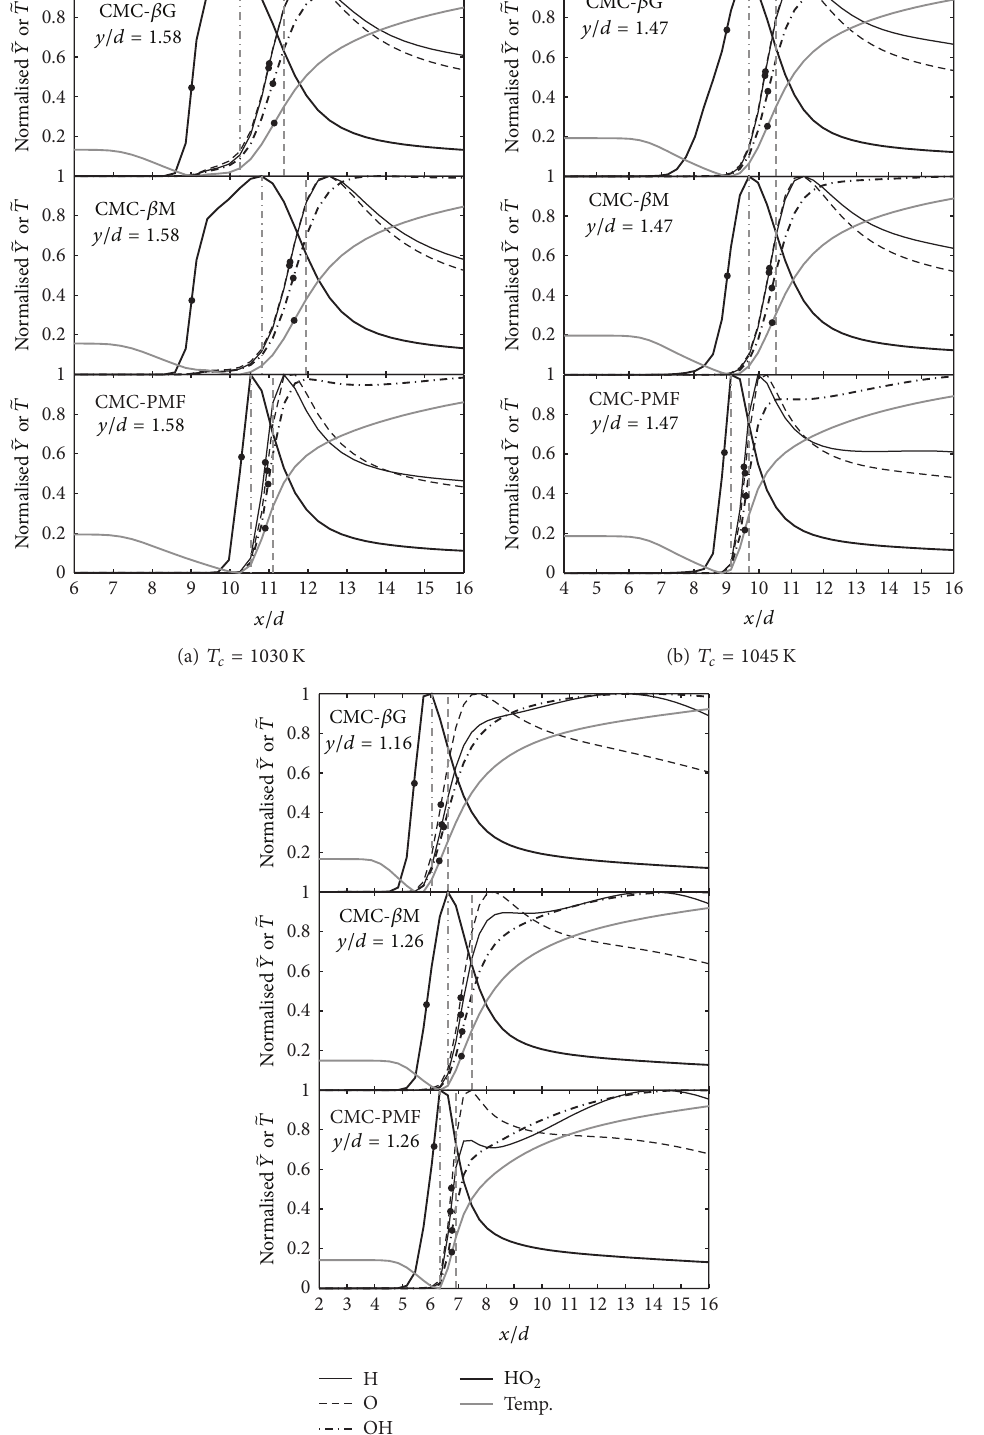
obtained using the three 2 and liftoff height, respectively. The circles indicate the locations of the 2